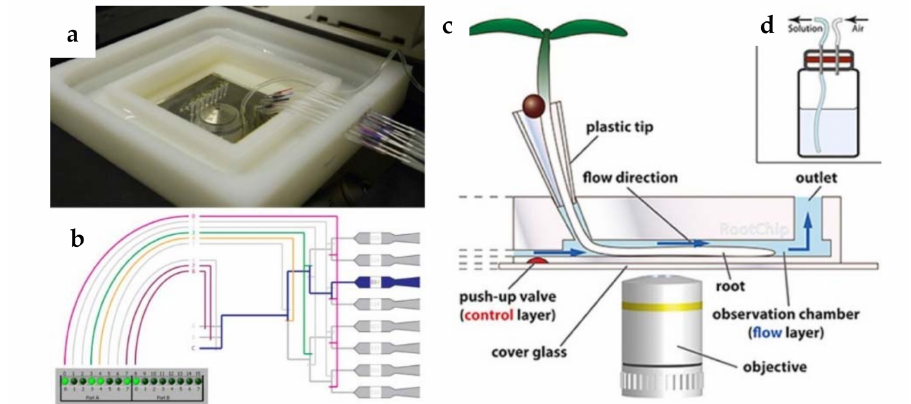
Figure 6. ( a ) Top view of the fully connected RootChip.; ( b ) the valving system and the controller interface; ( c ) image of the RootChip principle; ( d ) image of the pressurizable solution vial with diaphragm (adapted from [97] with